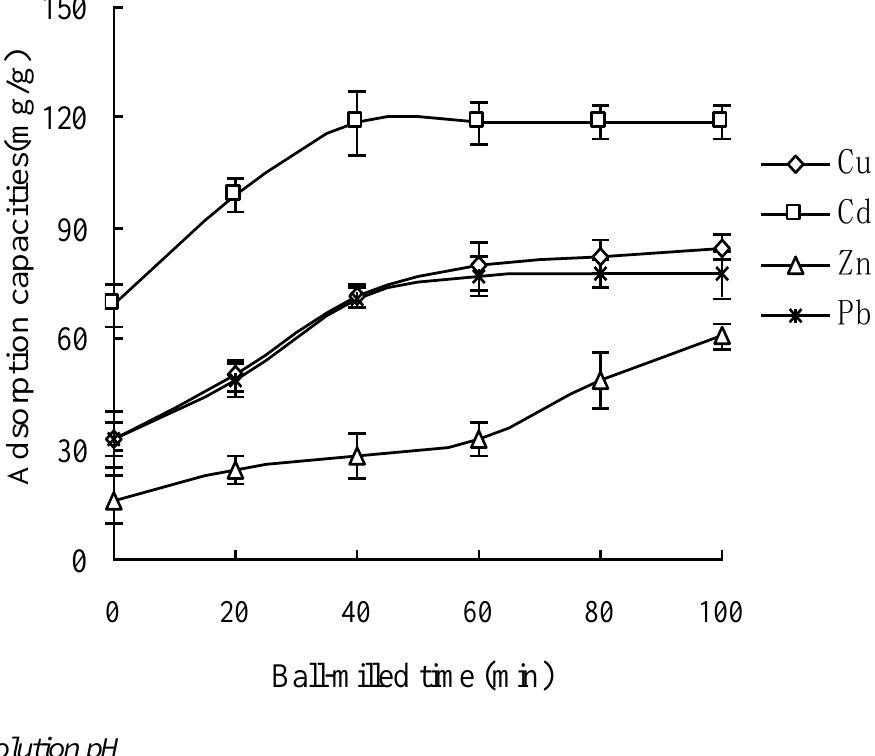
Figure 4. Influence of CCM size on adsorption capacities for heavy metal ions (initial metal concentration = 100 ppm; agitation speed = 180 rpm; equilibrium time = 2 h; temperature = 25 °C; dosage = 1.0 g/L; initial pH =